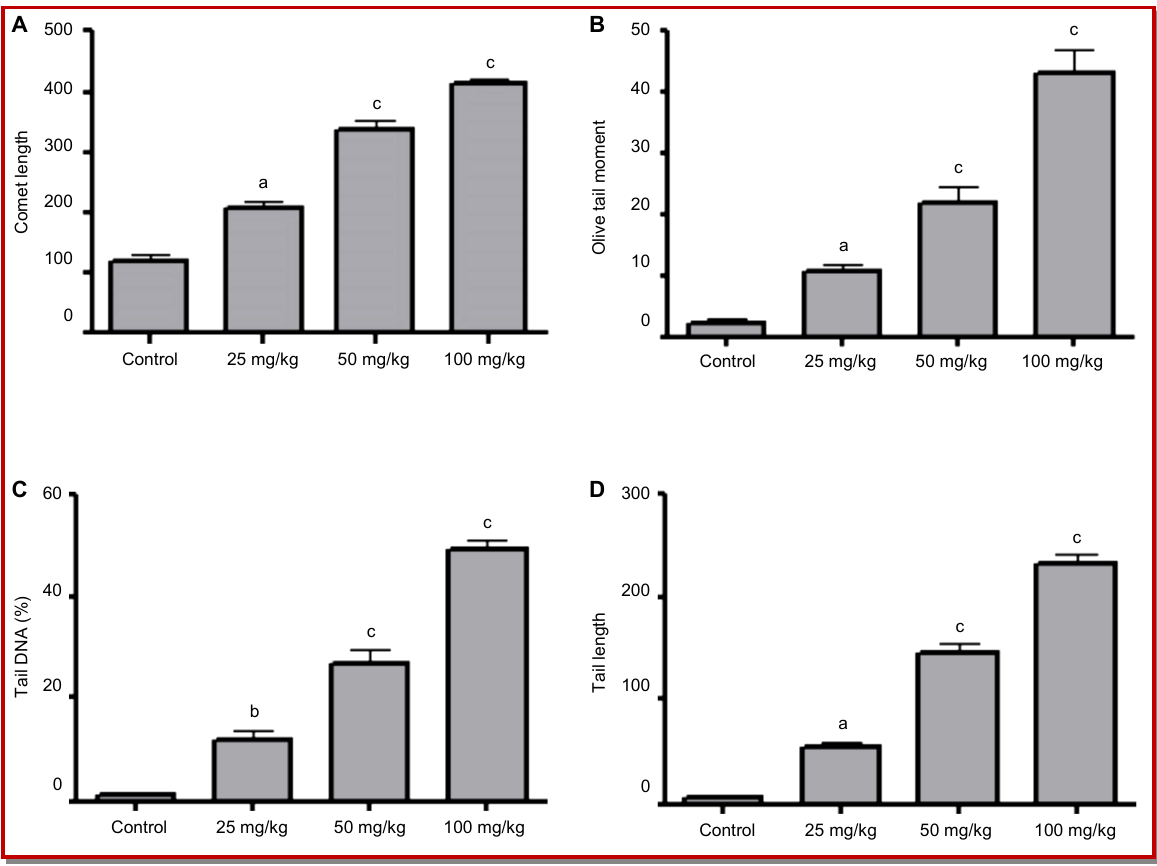
Figure 2: Bar diagrams showing the effect of lead on comet assay. Quantitative analysis of comet length (A), olive tail moment (B), tail DNA (C) and tail length (D) were carried out in rat blood cells following treatment with 0, 25, 50 and 100 mg/kg doses of lead for 5 consecutive days. Data are shown as mean ± SEM for separate groups of rats (n = 5). a p<0.05; b p<0.01; c p<0.001; (Bonferroni